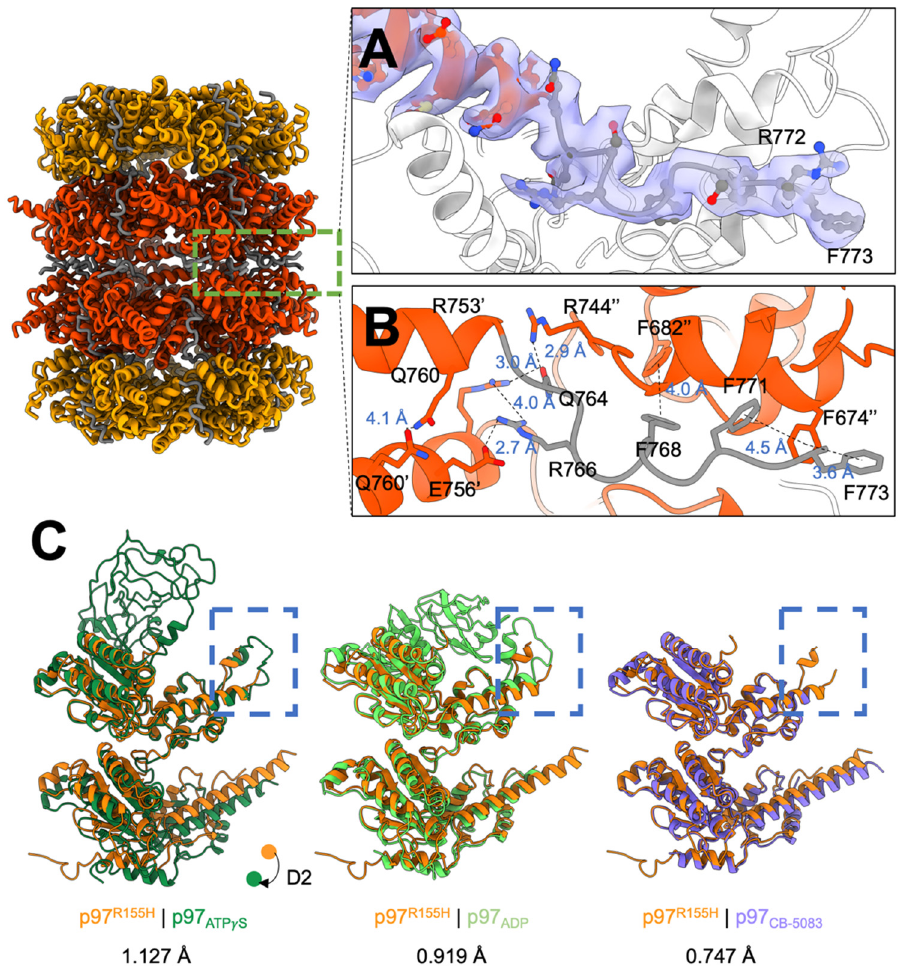
Figure 3. Cryo-EM structure of the p97 R155H dodecamer. Orange, orange-red, and grey indicate the D1, D2, and linker domains of the p97 R155H . ( A ) Cryo-EM density of the partial C-terminal tail. The purple surface shows the cryo-EM density (4.6 σ ). The side chains are shown in stick representation. ( B ) Interaction network of the binding interface of the two p97 R155H hexamers. The two hexamers interact via hydrogen bonds and π - π aromatic packing. ( C ) Superposition of the p97 R155H with p97 structures in different nucleotide states. Dark green, light green, and purple are p97 ATP γ S , p97 ADP , and p97 CB-5083 , respectively. RMSDs are 1.127 Å, 0.919 Å, and 0.747 Å for p97 ATP γ S , p97 ADP , and p97 CB-5083 , respectively. Blue rectangles highlight conformational changes in the D1 helix-turn-helix motif. The direction of the D2 movement upon ATP γ S binding is shown in dots and an arrow.